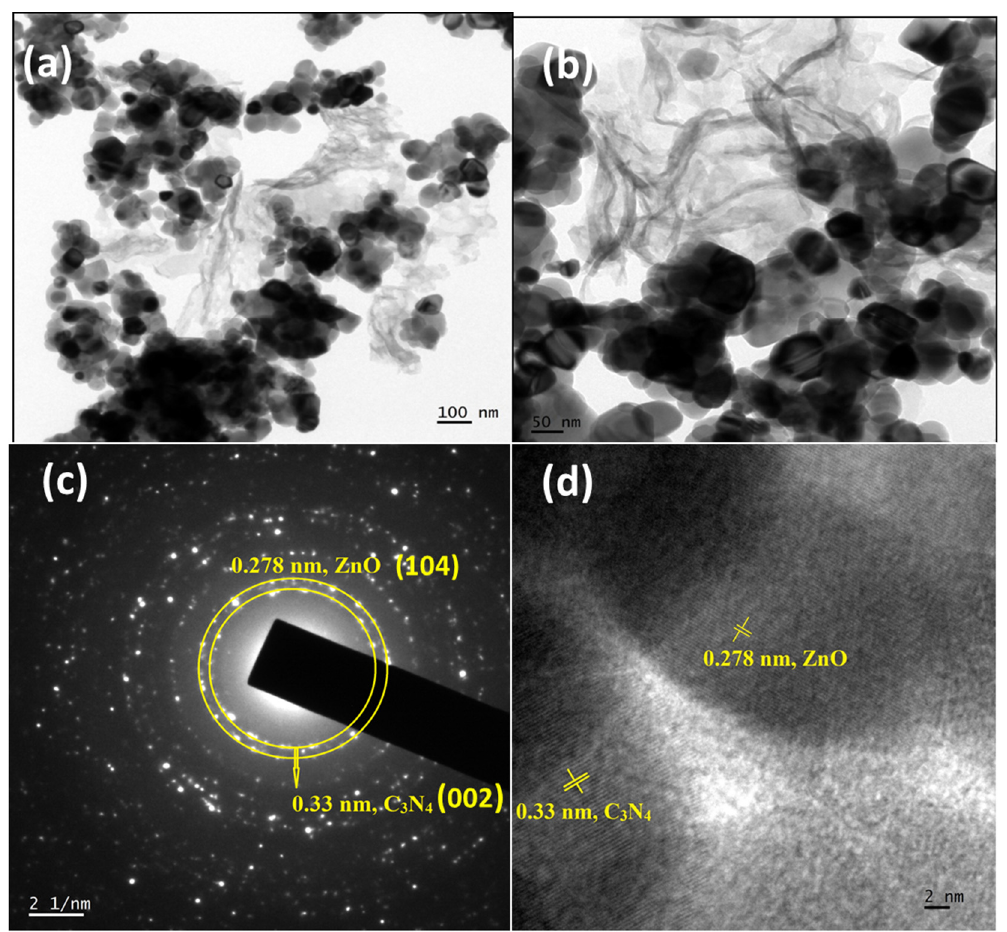
Figure 5. ( a , b ) TEM images of ZnO/C 3 N 4 (ZCN-5); ( c ) SAED pattern showing the d spacing of different lattice planes in ZnO/C 3 N 4 (ZCN-5); ( d ) HRTEM image of ZnO/C 3 N 4 (ZCN-5).